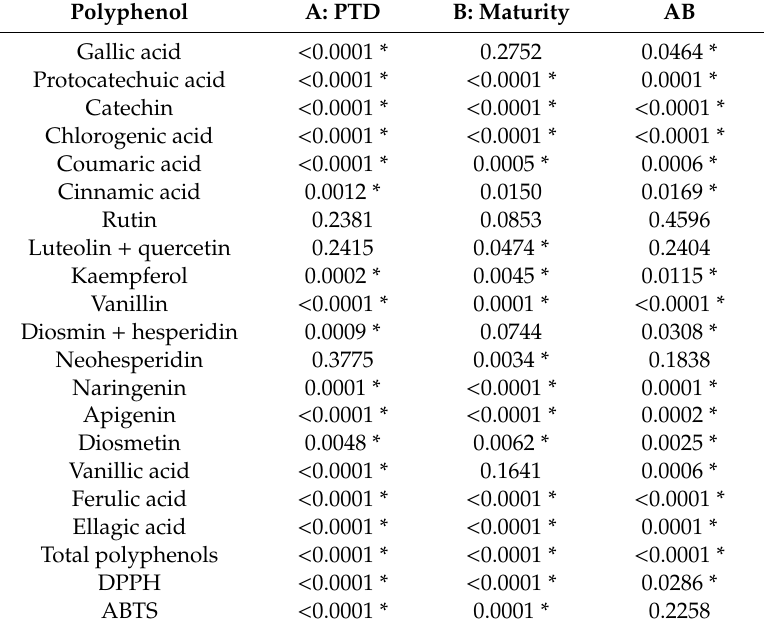
Table 2. P values of the di ff erent factors evaluated and their respective interactions for each quantified polyphenols, total polyphenols and antioxidant activity by DPPH (2,2-Diphenyl-1-picrylhydrazyl) and ABTS (2,2 (cid:48) -azino-di-3-ethylbenzthiazoline sulfonic acid). Polyphenol A: PTD B: Maturity AB Gallic acid < 0.0001 * 0.2752 0.0464 * Protocatechuic acid < 0.0001 * < 0.0001 * 0.0001 * Catechin < 0.0001 * < 0.0001 * < 0.0001 * Chlorogenic acid < 0.0001 * < 0.0001 * < 0.0001 * Coumaric acid < 0.0001 * 0.0005 * 0.0006 * Cinnamic acid 0.0012 * 0.0150 0.0169 * Rutin 0.2381 0.0853 0.4596 Luteolin + quercetin 0.2415 0.0474 * 0.2404 Kaempferol 0.0002 * 0.0045 * 0.0115 * Vanillin < 0.0001 * 0.0001 * < 0.0001 * Diosmin + hesperidin 0.0009 * 0.0744 0.0308 * Neohesperidin 0.3775 0.0034 * 0.1838 Naringenin 0.0001 * < 0.0001 * 0.0001 * Apigenin < 0.0001 * < 0.0001 * 0.0002 * Diosmetin 0.0048 * 0.0062 * 0.0025 * Vanillic acid < 0.0001 * 0.1641 0.0006 * Ferulic acid < 0.0001 * < 0.0001 * < 0.0001 * Ellagic acid < 0.0001 * < 0.0001 * 0.0001 * Total polyphenols < 0.0001 * < 0.0001 * < 0.0001 * DPPH < 0.0001 * < 0.0001 * 0.0286 * ABTS < 0.0001 * 0.0001 *